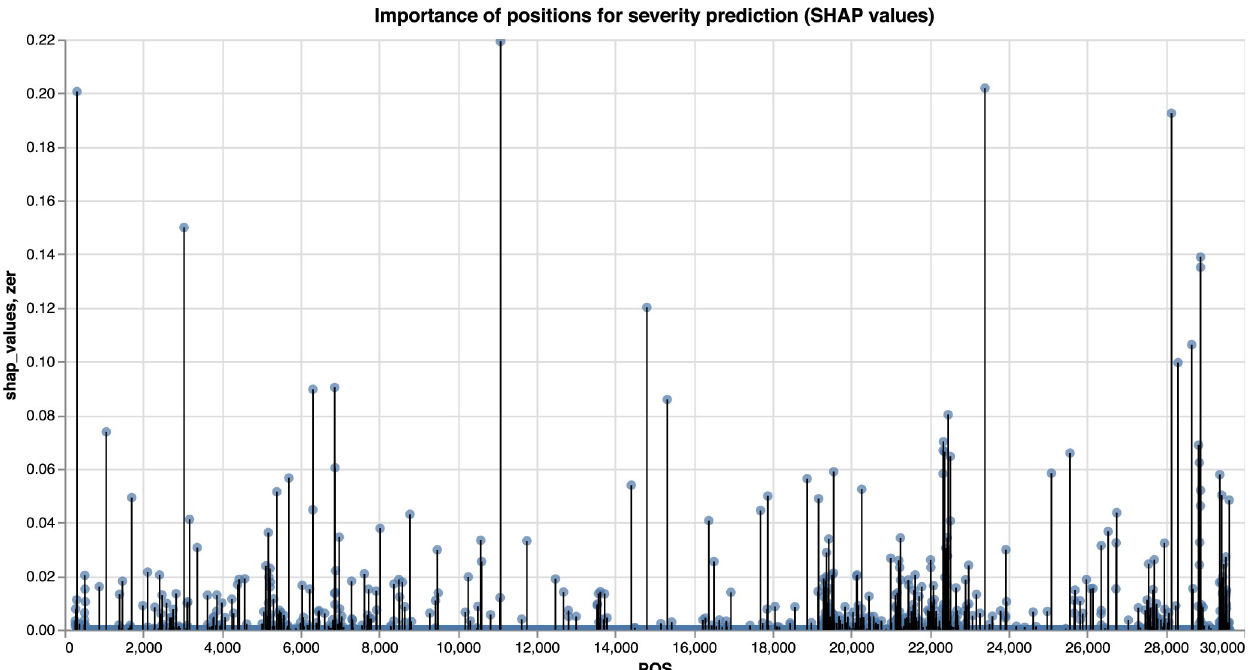
Fig 8. Feature importance analysis using SHAP method. Manhattan plot. Feature importance based on the LGBM model, computed using the SHAP method.